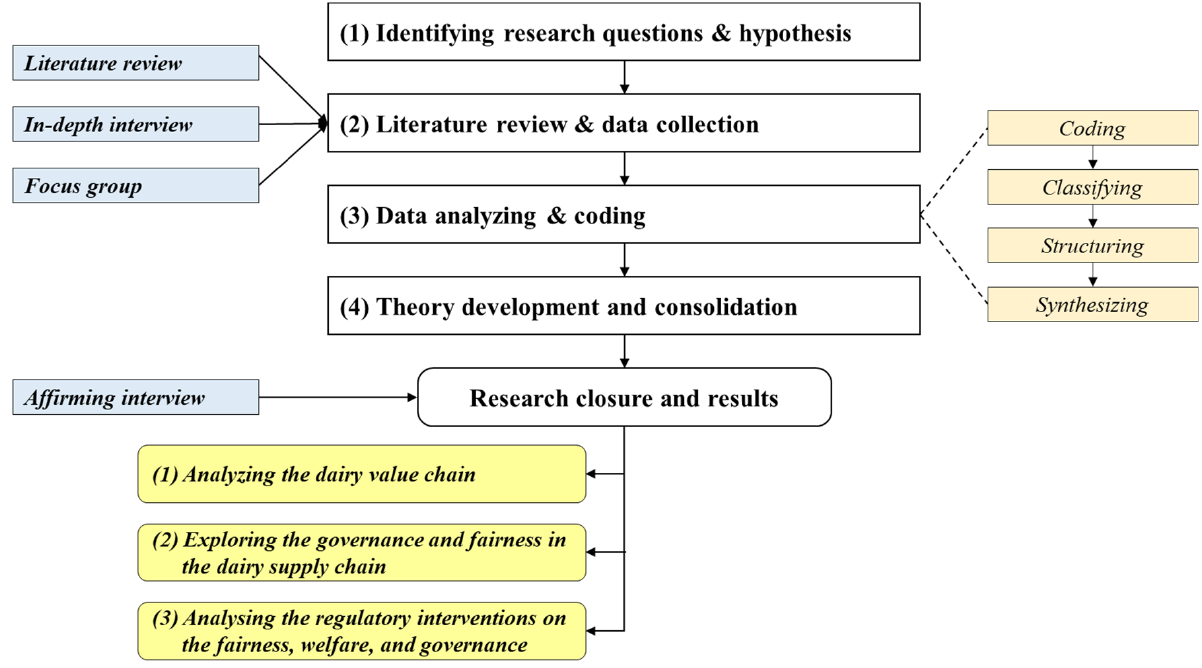
Figure 1. The qualitative research framework. Source: Bitsch [43], Charmaz and Belgrave [44], and Winsen et al. [45].